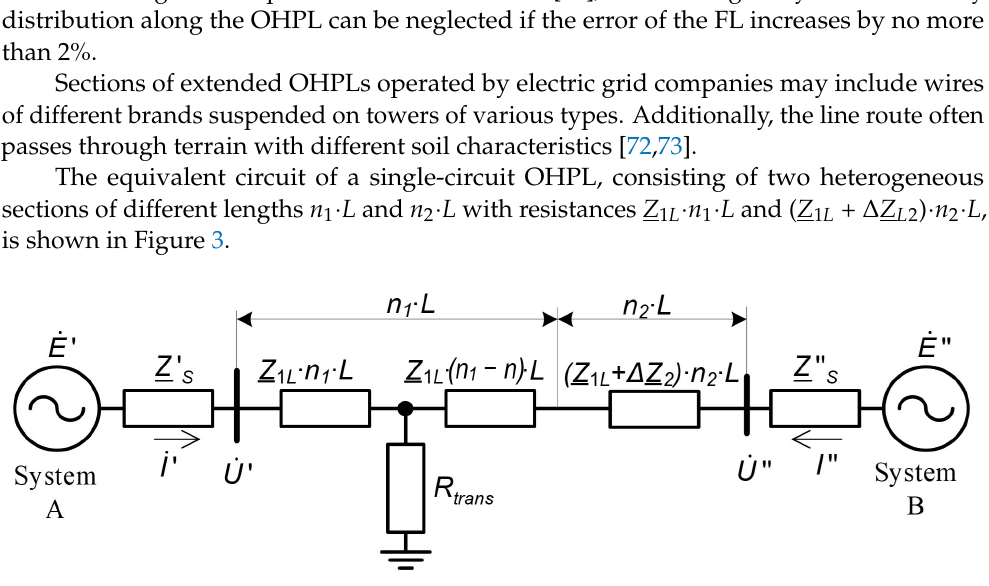
Figure 3. Equivalent circuit of a heterogeneous single-circuit OHPL with two sections.